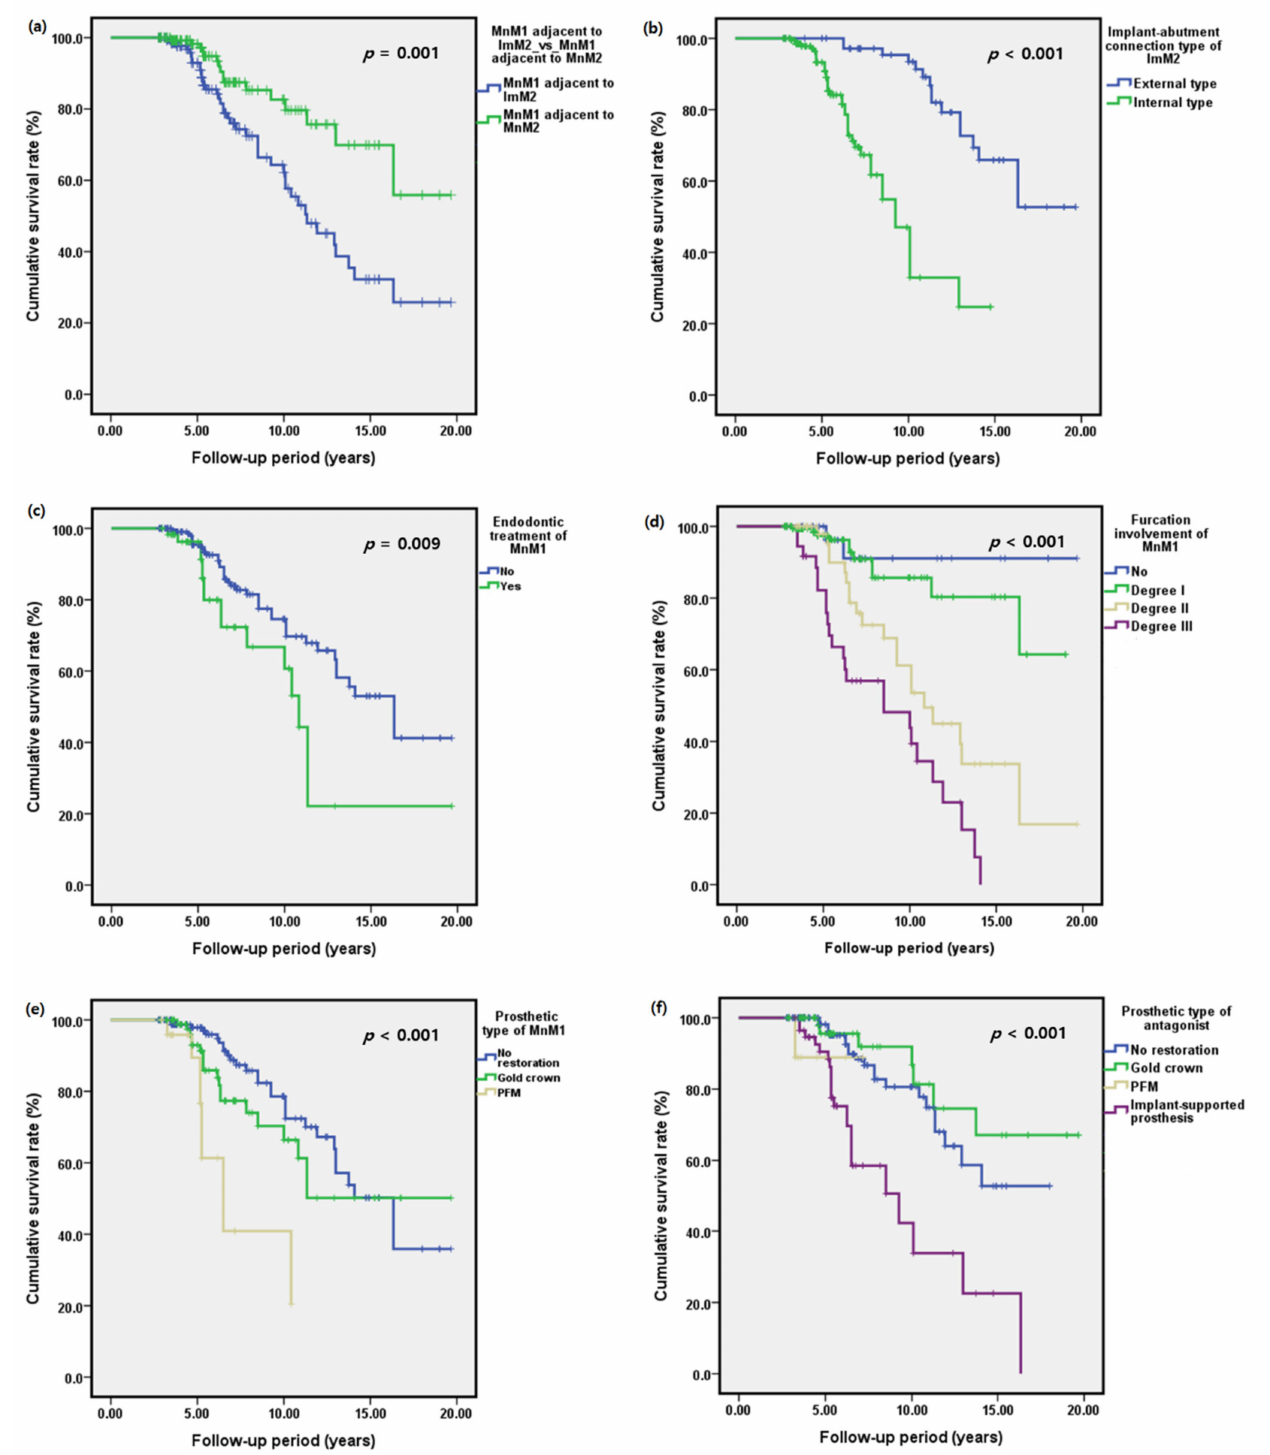
Figure 5. Kaplan–Meier survival curves. ( a ) The cumulative survival rate of the mandibular first molars (MnM1s) adjacent to implants (ImM2s) was significantly lower than MnM1s adjacent to the mandibular second molars (MnM2s) at the 5-year follow-up. The cumulative survival rate of the mandibular first molars adjacent to ImM2s or MnM2s according to ( b ) implant-abutment connection type of ImM2s, ( c ) history of endodontic treatment of MnM1s, ( d ) degree of furcation involvement of MnM1s, ( e ) the prosthetic material types of MnM1s and ( f ) the prosthetic material types of the antagonists of